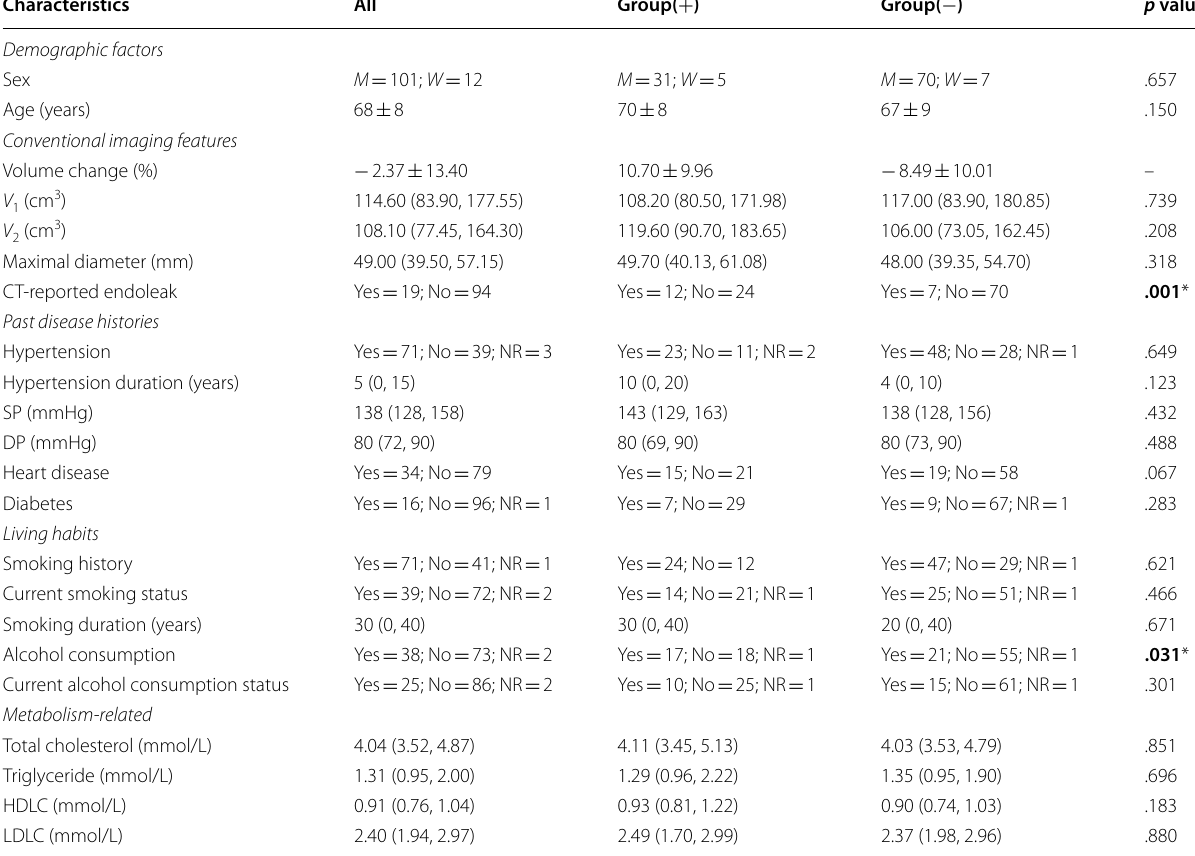
Table 1 Conventional imaging features and clinical risk factors